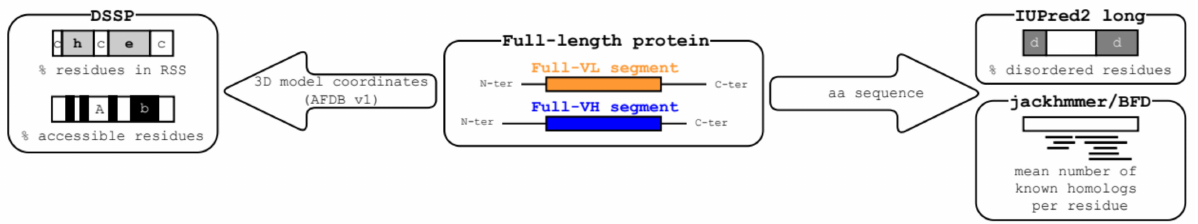
Figure 2. The technical flow for feature description of the segment dataset. Each AFDB v1 full- length protein comprising at least one full-VL or one full-VH long soluble-like foldable segment was analyzed by different tools (DSSP on the 3D coordinates, IUPred2 long , and jackhmmer on the amino acid sequence) allowing for calculation of four quantitative features describing each segment. Labels used for the different tools are: (i) for DSSP secondary structure assignment: h, helix; e, strand (extended); c, coil; (ii) for DSSP solvent accessibility: A, accessible, b, buried; (iii) for IUPred2 long: d,